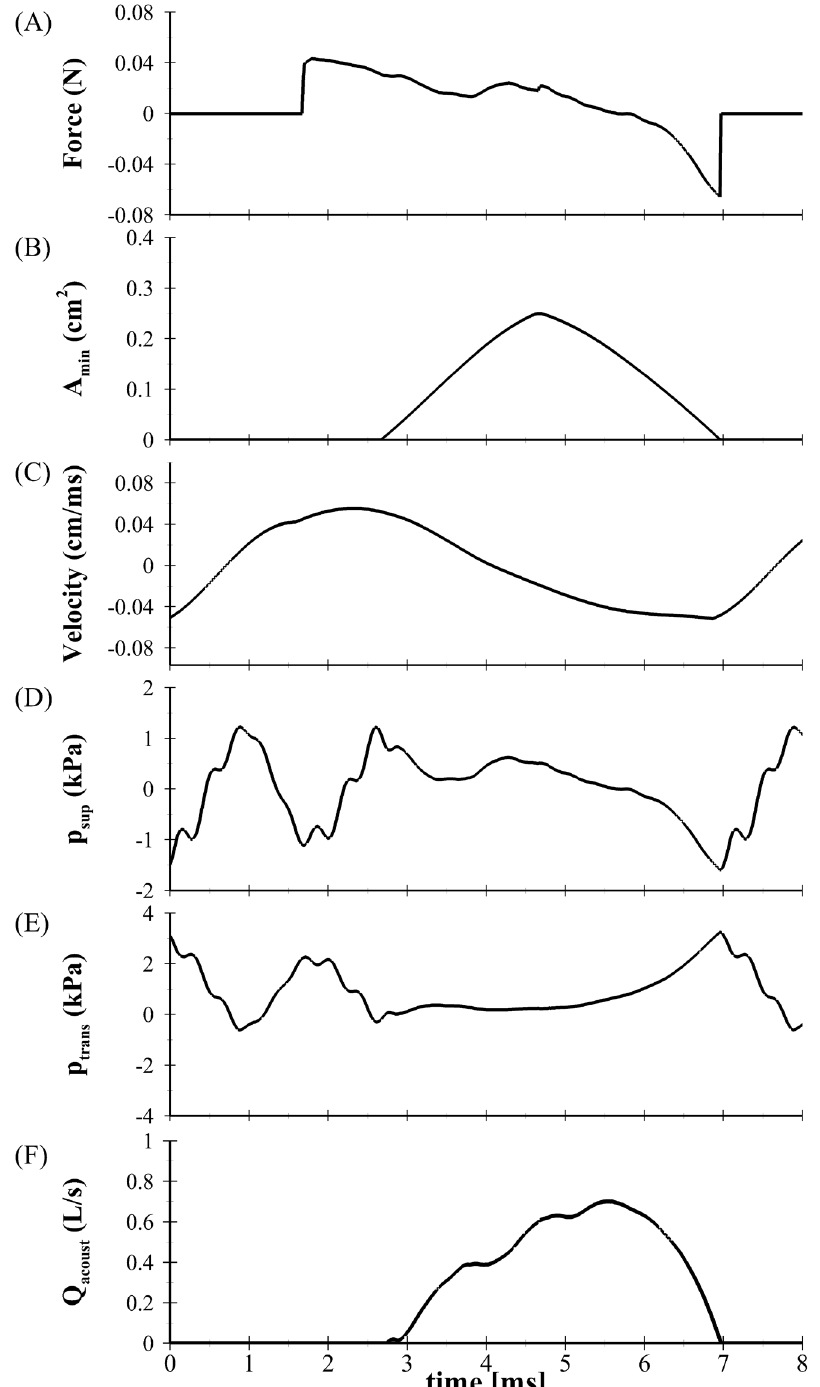
Fig 5. One oscillatory cycle of the aerodynamic parameters produced with the BLAST (case 3) solver. The solution is provided for p s = 1.0 kPa and Z = 1.0. A: fluid loading, B: minimum glottal area, C: velocity of mass 1, D: supraglottal pressure, E: transglottal pressure, and F: flow rate.